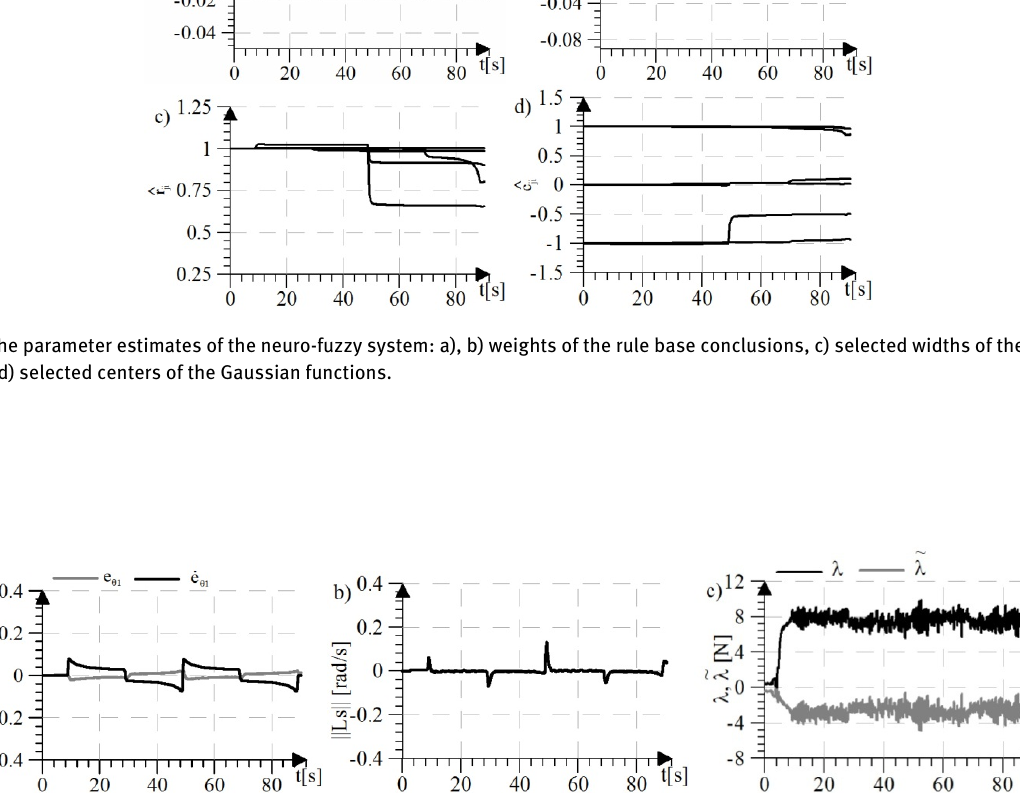
Figure 9: The motion error and its derivative, b) the form of the filtered motion error, c) the realised downforce and the force